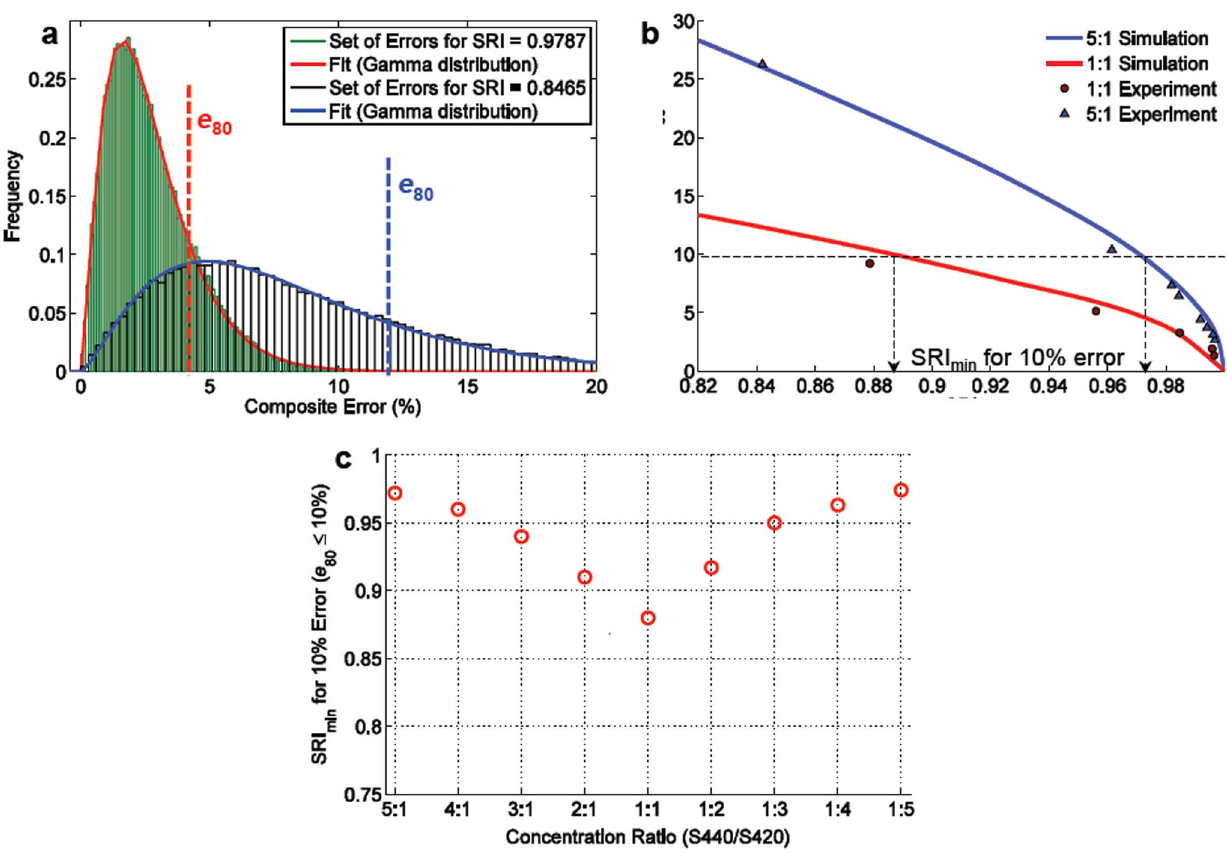
Figure 5. Spectral quality characterization of two-flavor mixtures. (a) Composite errors for multi-particle mixtures are gamma-distributed. Vertical lines indicate bounds for the 80 th percentile of error values ( e 80 ) that may occur for a particular SRI. (b) A plot of error ( e 80 ) vs. SRI for a 1:1 mixture of particle flavors and a 5:1 mixture of flavors. Simulations (solid lines) closely predict experimental results. (c) A plot of the minimum SRI required to ensure a composite error # 10% with 80% confidence. This dual-flavor example shows how the minimum SRI value depends upon the mixture ratio.